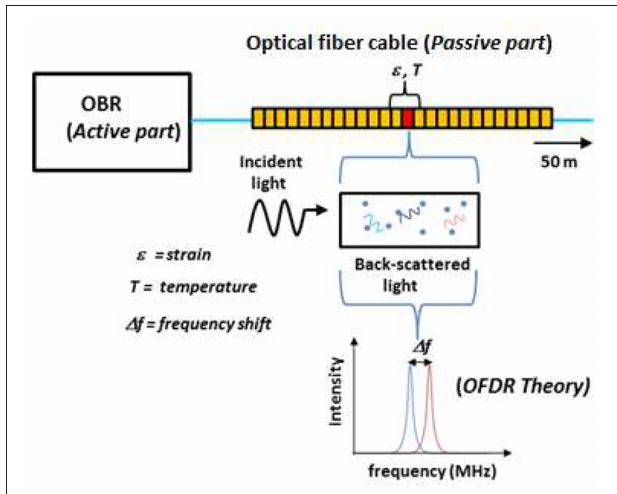
FIGURE 1 | Measuring process by OBR